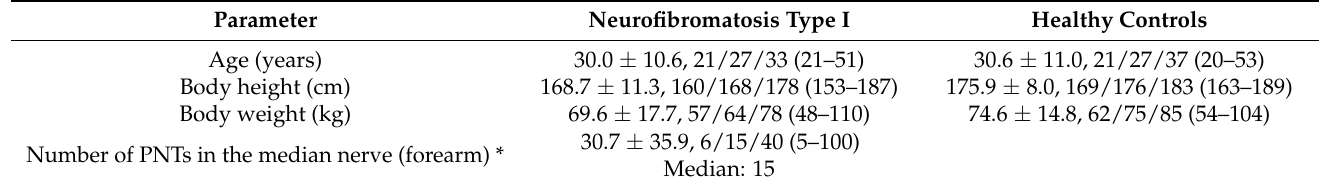
Table 1. Demographic details about patients with neurofibromatosis type I and healthy